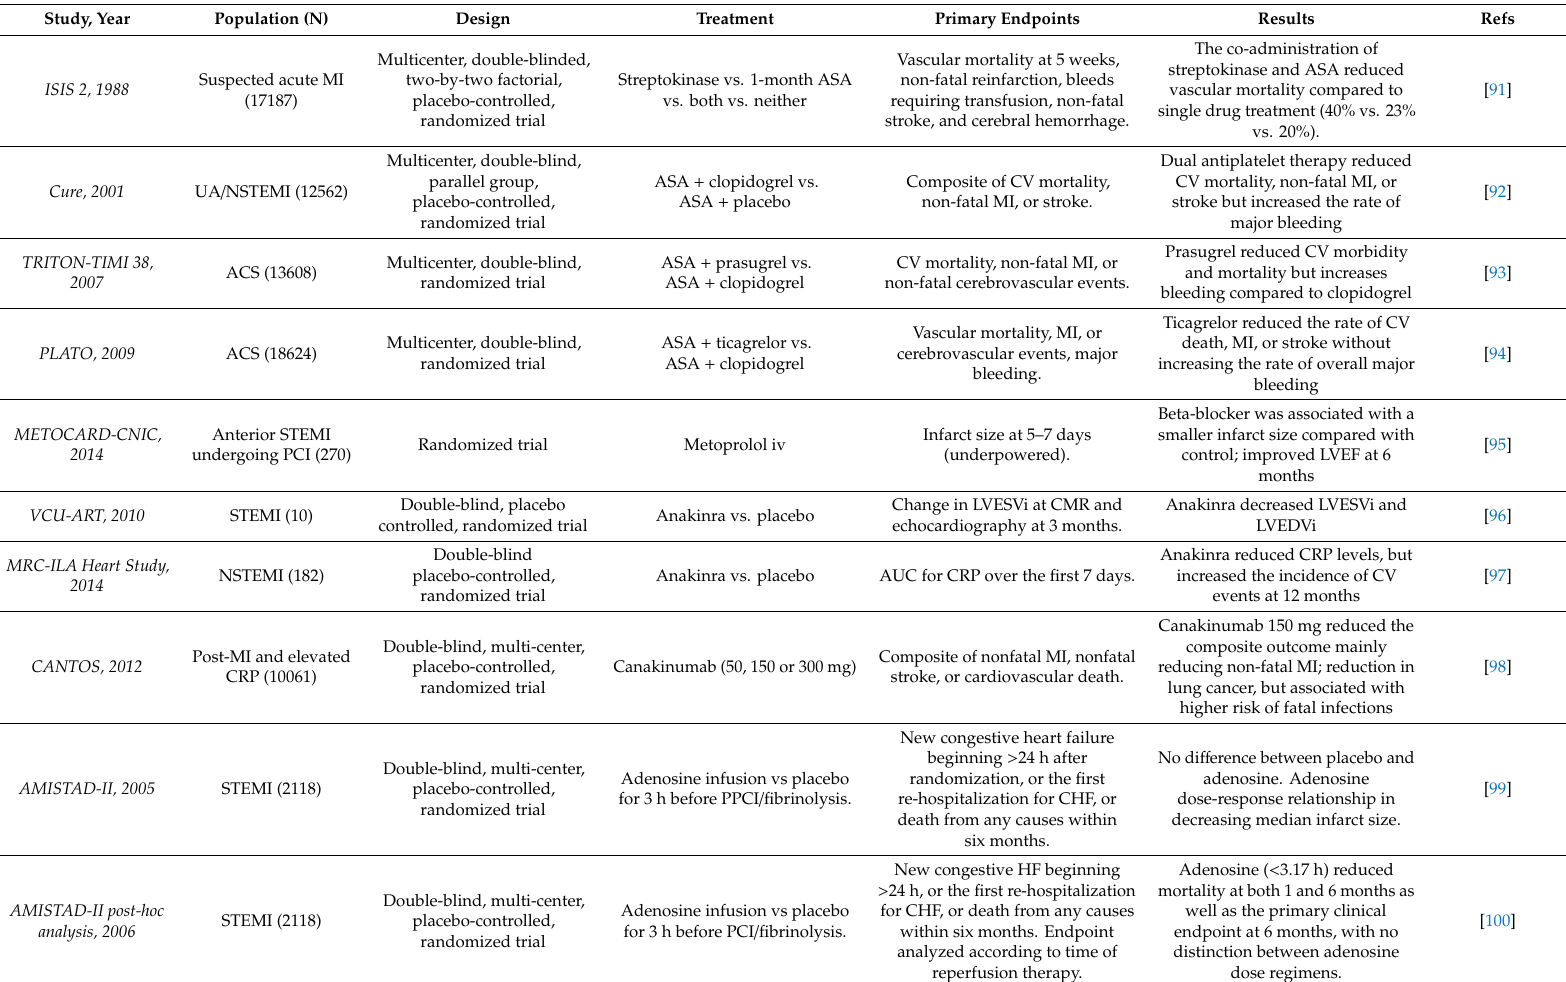
Table 1. Therapeutic strategies to reduce ischemic damage and reperfusion